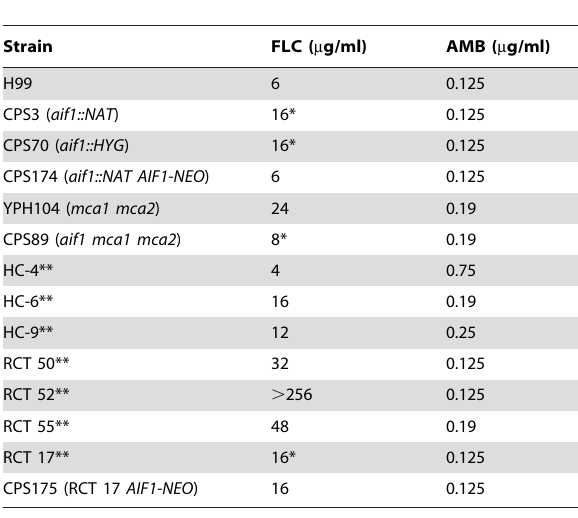
Table 1. Minimal inhibitory concentration (MIC, m g/ml) found in Etest